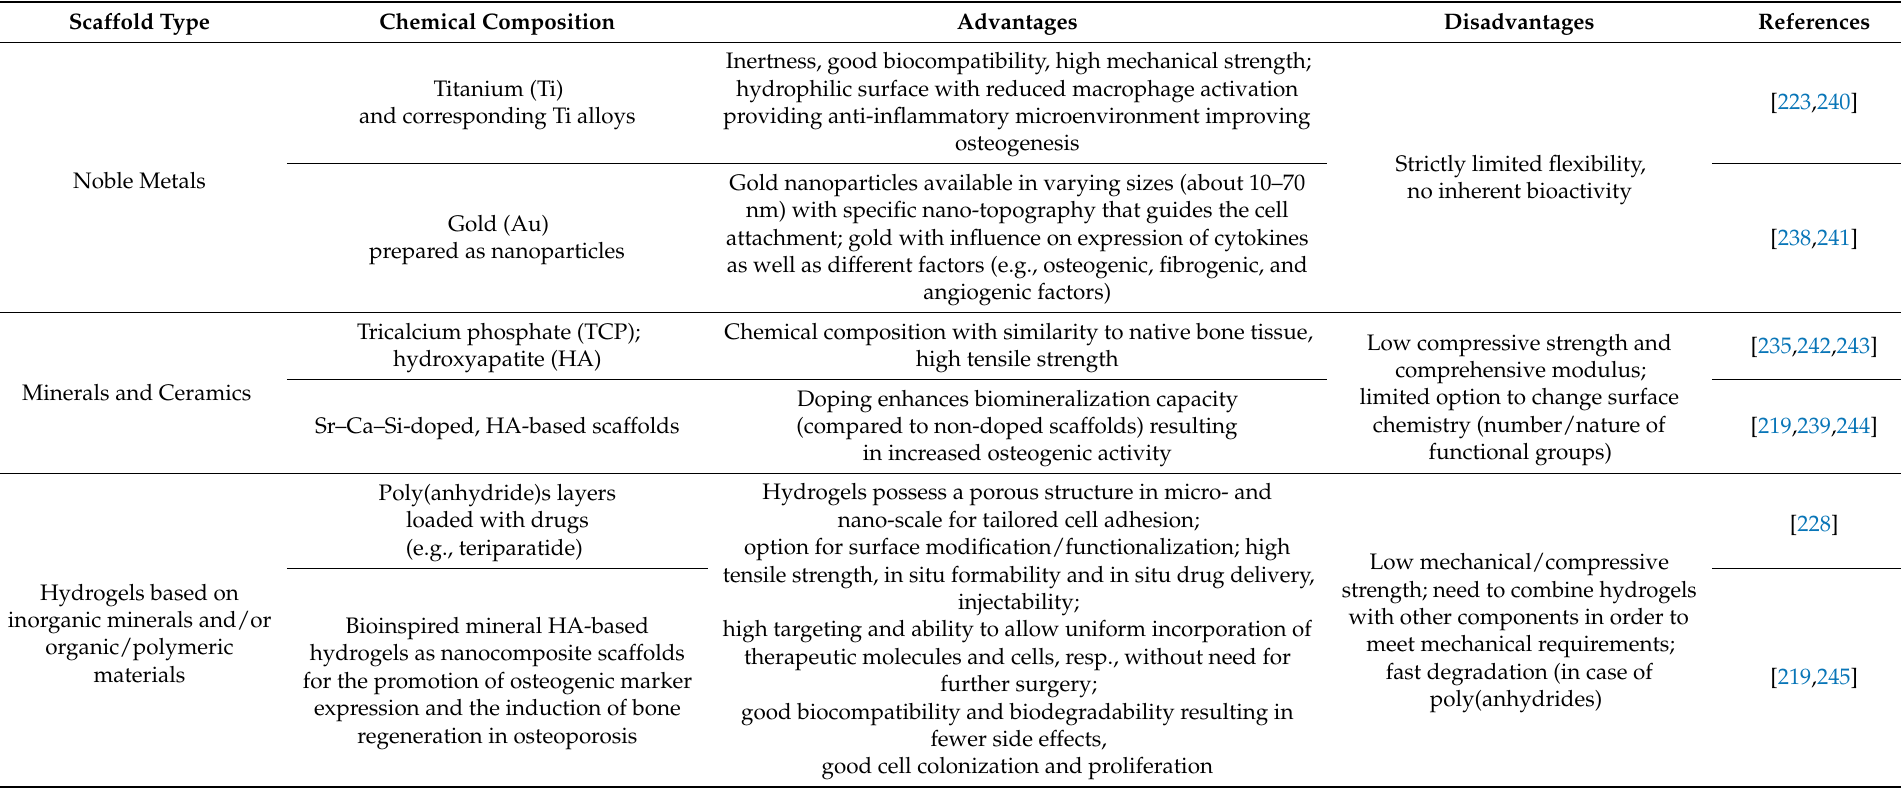
Table 2. Current scaffold materials used in osteoporosis treatment with their advantages and